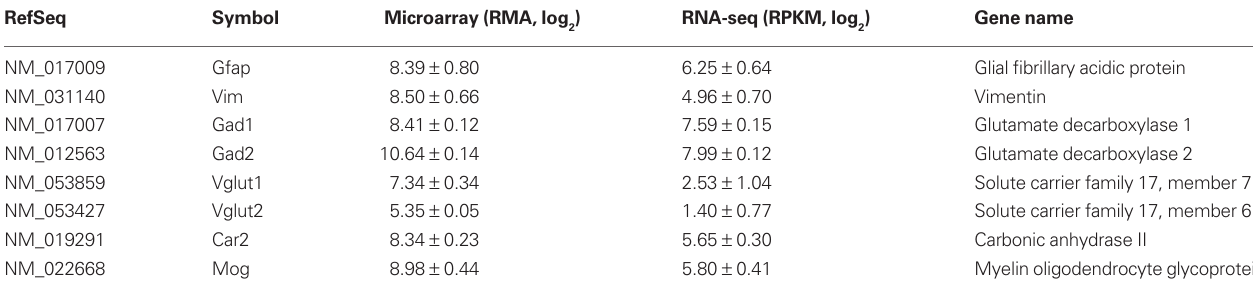
FiGuRe 7 | Comparison of the variances between microarray and RNA-seq. (A) The coefficient of variation for each gene was plotted against its signal intensity obtained from microarray. (B) The coefficient of variation for each gene was plotted against its signal intensity obtained from RNA-seq. (C) The distribution of the CVs for low abundance genes showed microarray has less Table 2 | expression of cellular marker